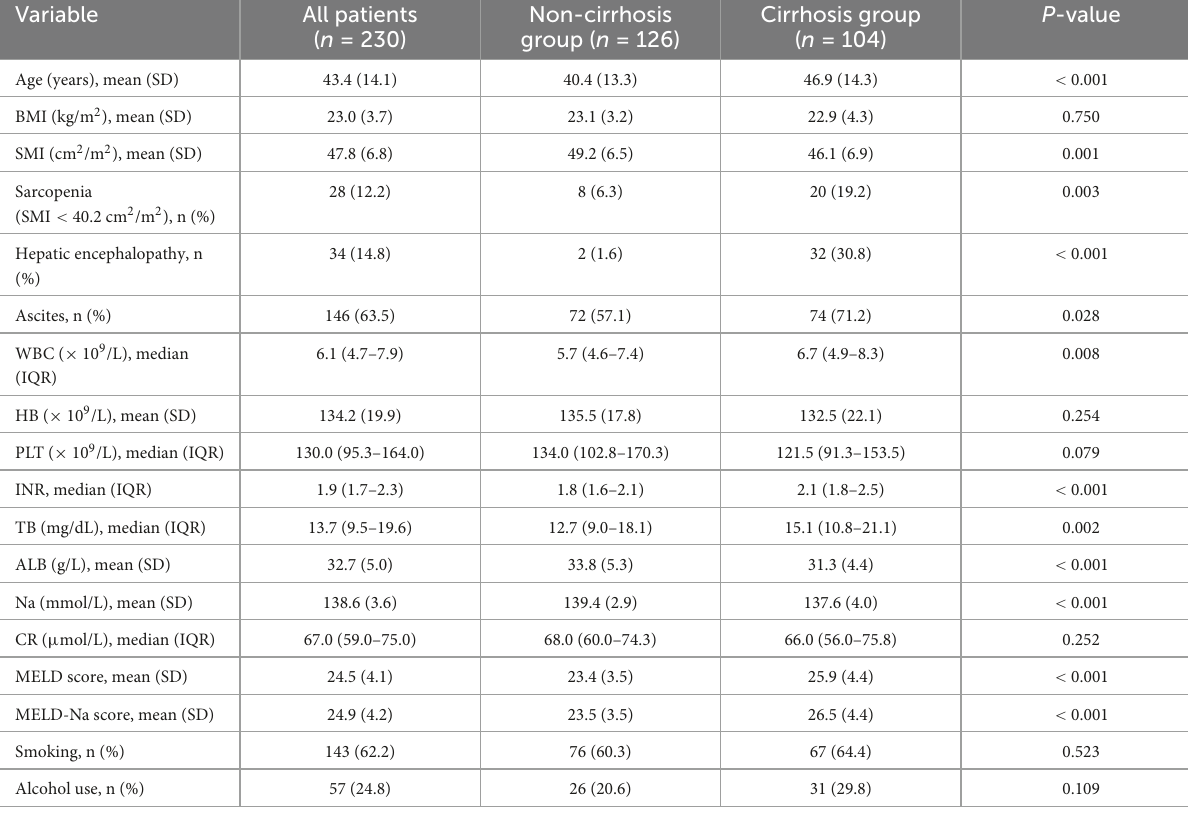
TABLE 1 The baseline characteristics between cirrhosis and non-cirrhosis groups.